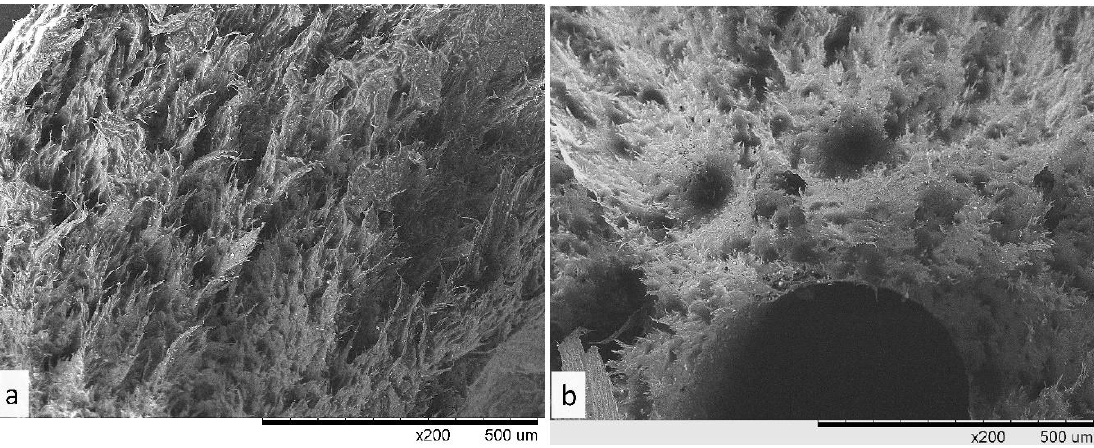
Figure 7. SEM images of the rupture surface after tensile test of F2nP10Q ( a ) and F5nP10Q ( b ).